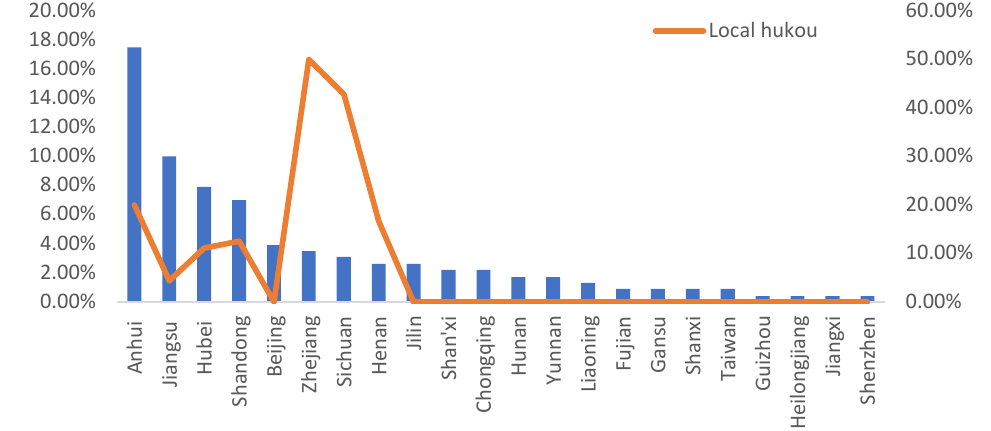
Figure 4. Places of origin of the respondents. (Source: survey by the authors, 2018).